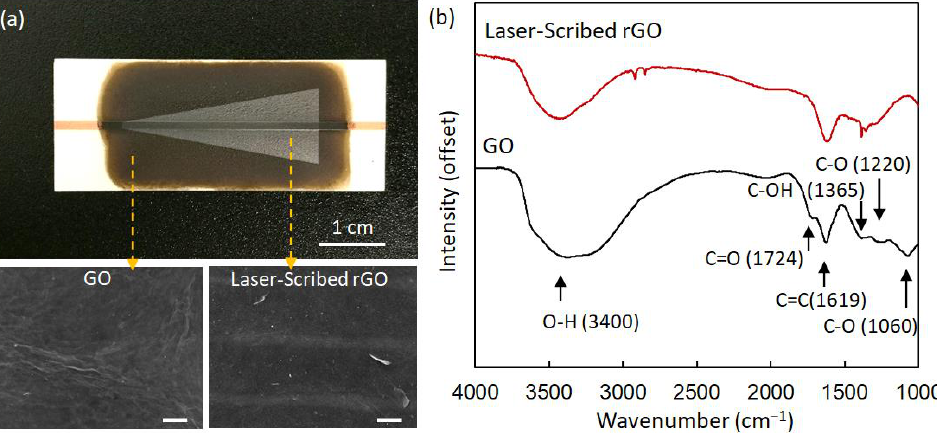
Figure 6. ( a ) Laser-scripted open-end termination. The insets are the scanning electron microscope (SEM) images of the GO and laser-scribed rGO film with a laser power of 40 mW. The scale bar indicates 20 μ m. ( b ) the Fourier transform infrared spectroscopy (FTIR) spectra of the GO and laser-scribed rGO film.